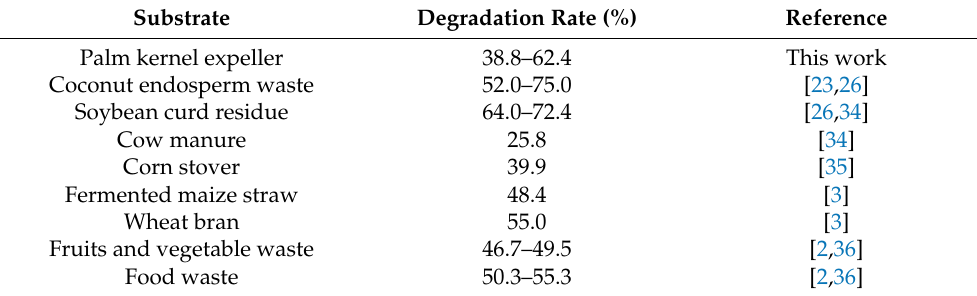
Figure 6. Degradation rates of palm kernel expeller executed by black soldier fly larvae upon inoculation with various volumes of R. oligosporus . Table 2. Degradation rates of different organic substrates after black soldier fly larvae treatments.